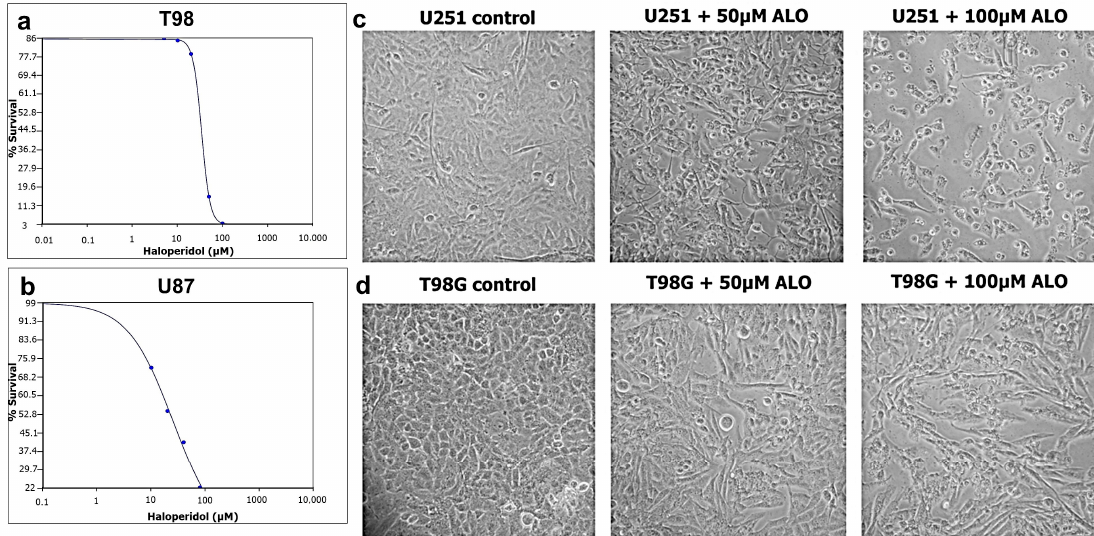
Figure 1. Viability of glioma cells following haloperidol (ALO) treatment. Cell viability was assessed by the trypan blue exclusion test and MTT in T98 ( a ) and U87 ( b ) glioma cells. Viability tests were performed 72 h after haloperidol treatment. Values shown are the means and standard deviations from the three independent experiments. Values are normalized to non-treated cells (* p < 0.05 vs. control). ( c ) Microscopy (100 × ) observation of the U251 and T98 ( d ) cell lines after treatment with haloperidol (50 and 100 µ M) for 72 h.